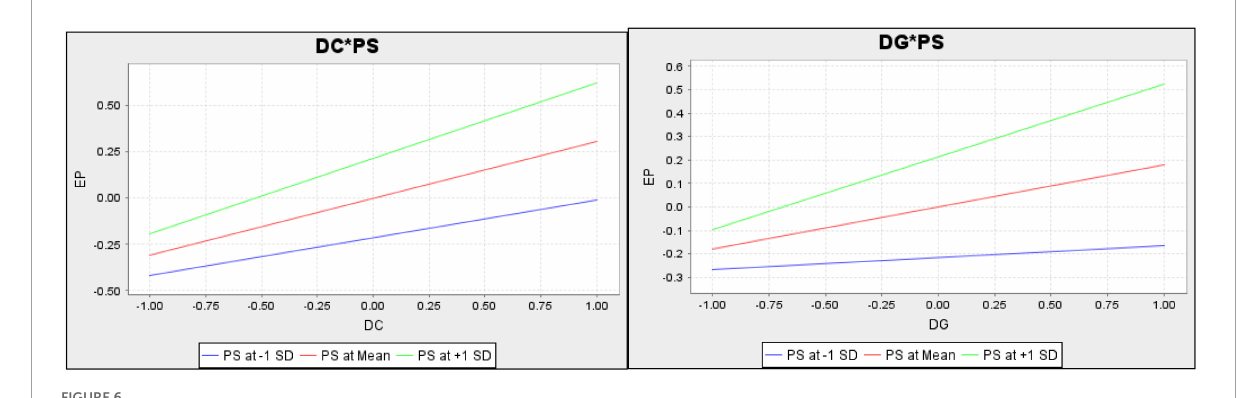
FIGURE6 Moderation